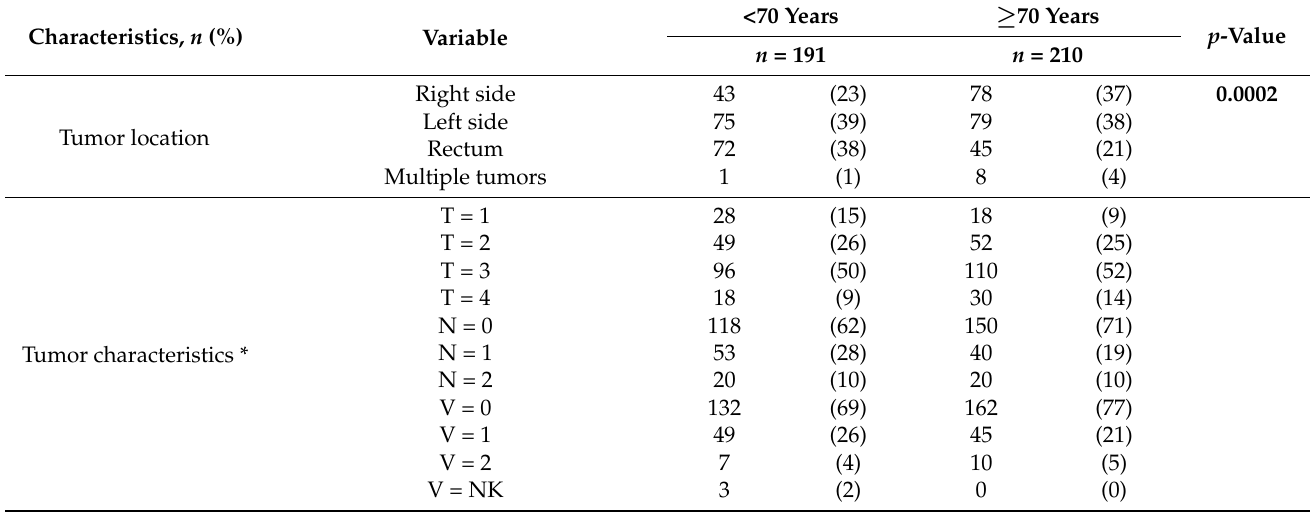
Table 2. Histopathological characteristics and type of operation in relation to